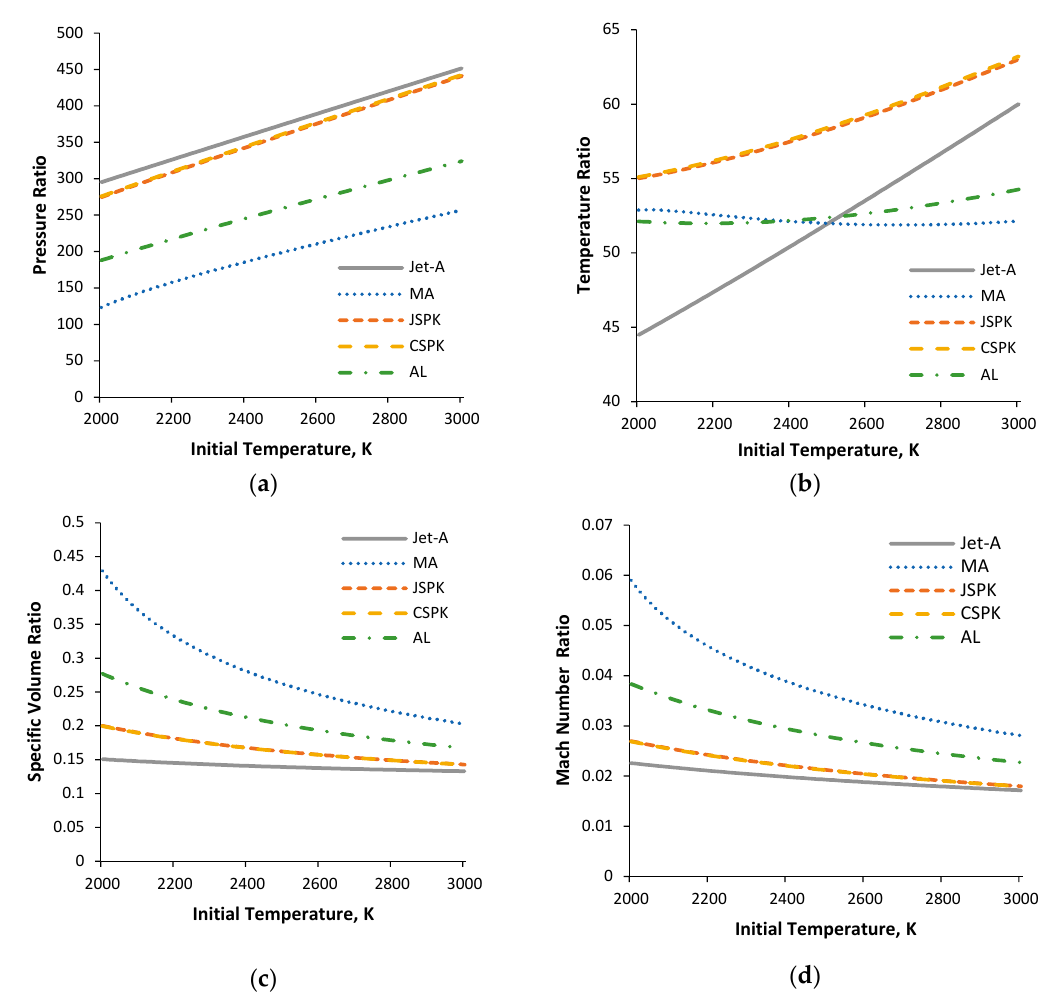
Figure 6. Comparison of ( a ) pressure ratios; ( b ) temperature ratios; ( c ) specific volume ratios; ( d ) and Mach number ratios at different initial temperature under influence of strong detonation (P = 1 atm, G = 6000 kg/s·m 2 ).